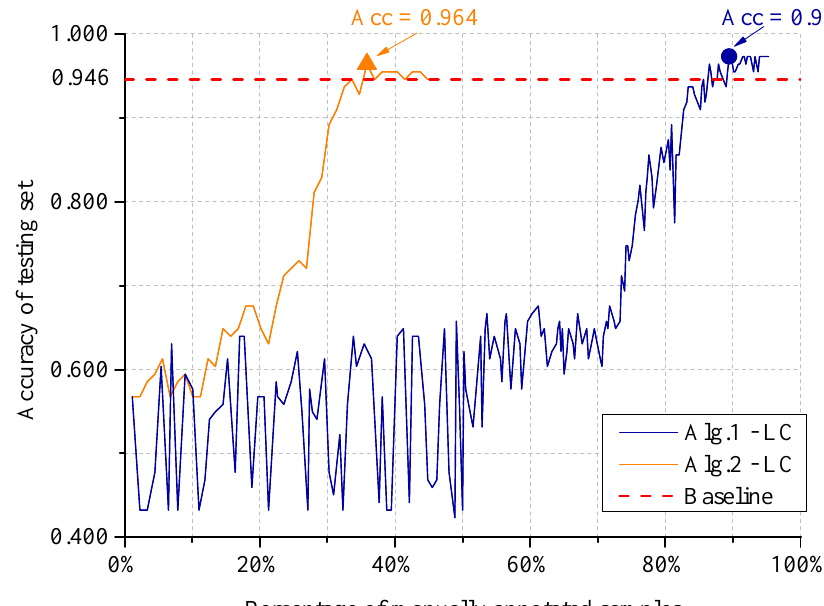
Figure 7. Comparison of Algorithms 1 and 2 using different percentage of training annotated samples, with the active learning algorithm of least confidence (LC). In the baseline model, the whole training set are manually labeled.